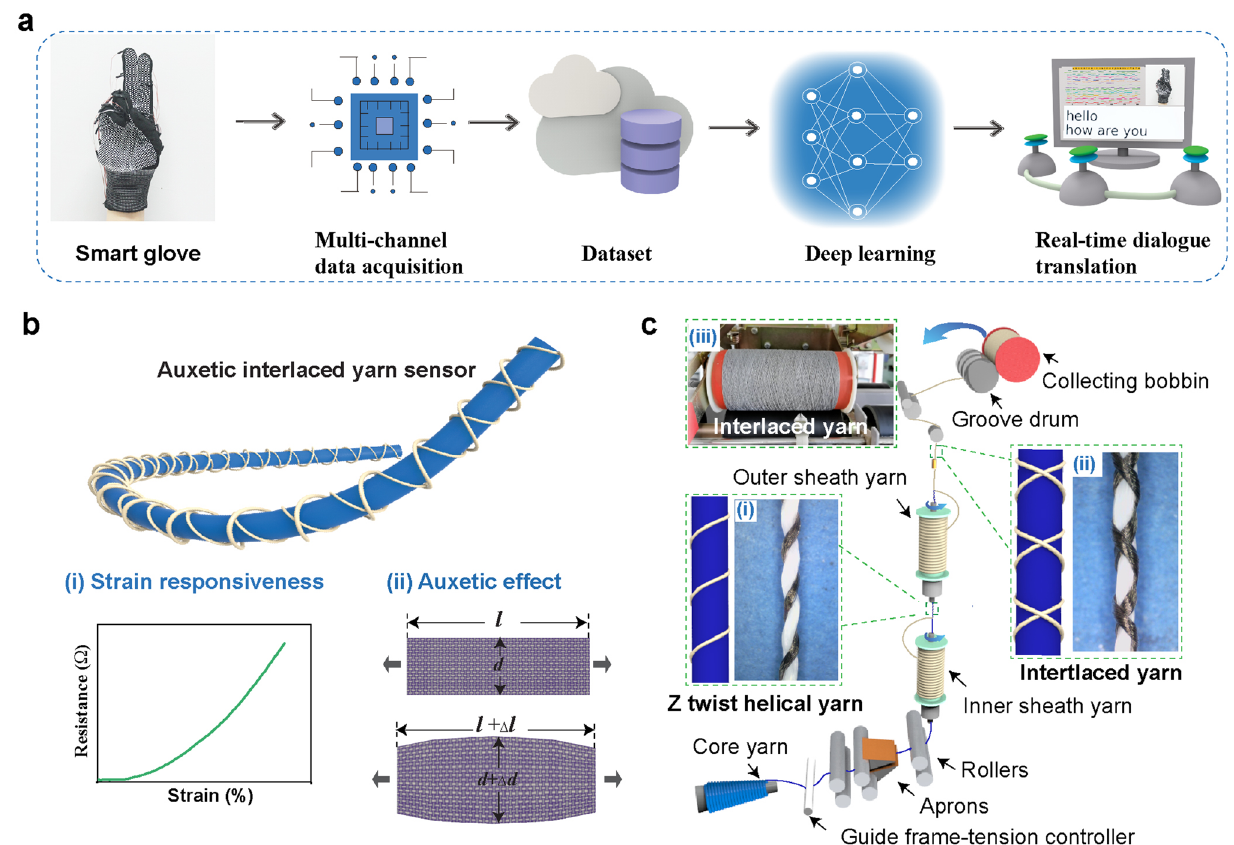
Fig. 1 Schematic illustration of the sign-language translation glove based on auxetic yarn sensor array. a Diagram of the real-time sign-lan- guage translation, showing signal acquisition, data processing, and deep learning paths from the AIYS-array-embedded smart glove to the sign- language translation. b Architecture of the AIYS and illustration of its strain responsiveness and auxetic effect. c Schematic illustration of the continuous yarn-wrapping technology. Insets (i) and (ii) are optical images of the Z-twist helical yarn and interlaced-helical yarn, and (iii) is a picture of collecting bobbins with the